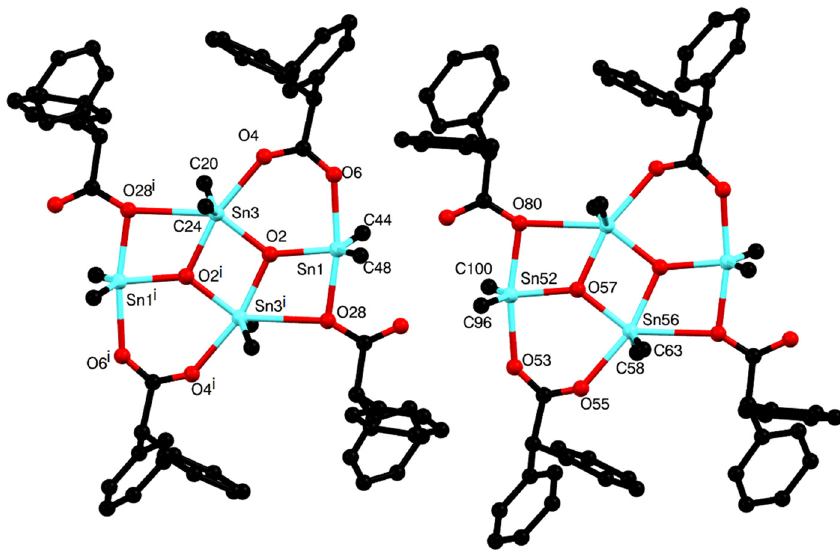
Figure 4: The ladder structure of aggregate complex 2 ( hydrogen atoms bonded to carbon atoms are omitted, and only the α - carbon of the butyl groups has been drawn for clarity ) .